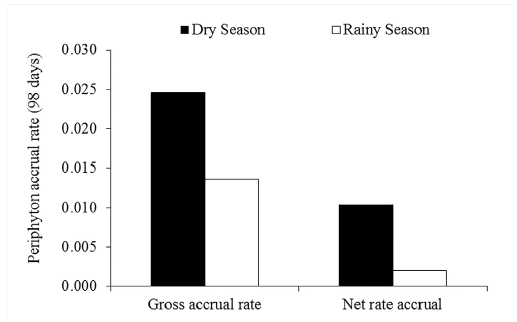
Figure 4. Periphyton gross and net accrual rate during 98 days of colonization in a shallow mesotrophic reservoir.